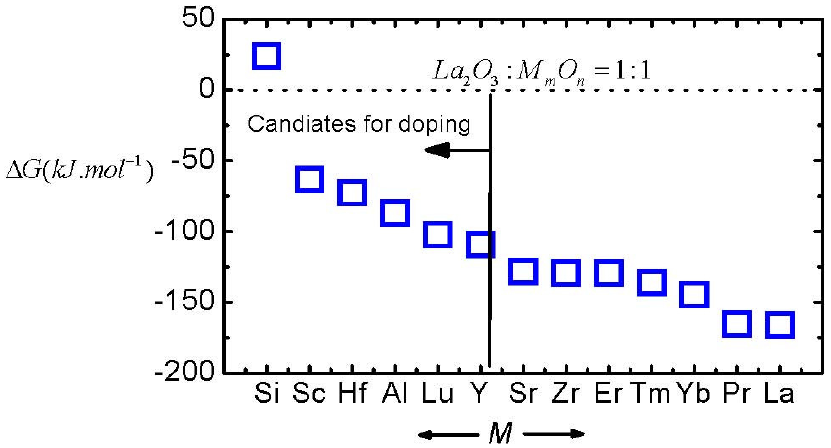
Figure 8. The G ∆ of the moisture absorption reactions of La-based ternary oxides, calculated by averaging the G ∆ of La between La O and the second oxide in ternary oxides is 2 3